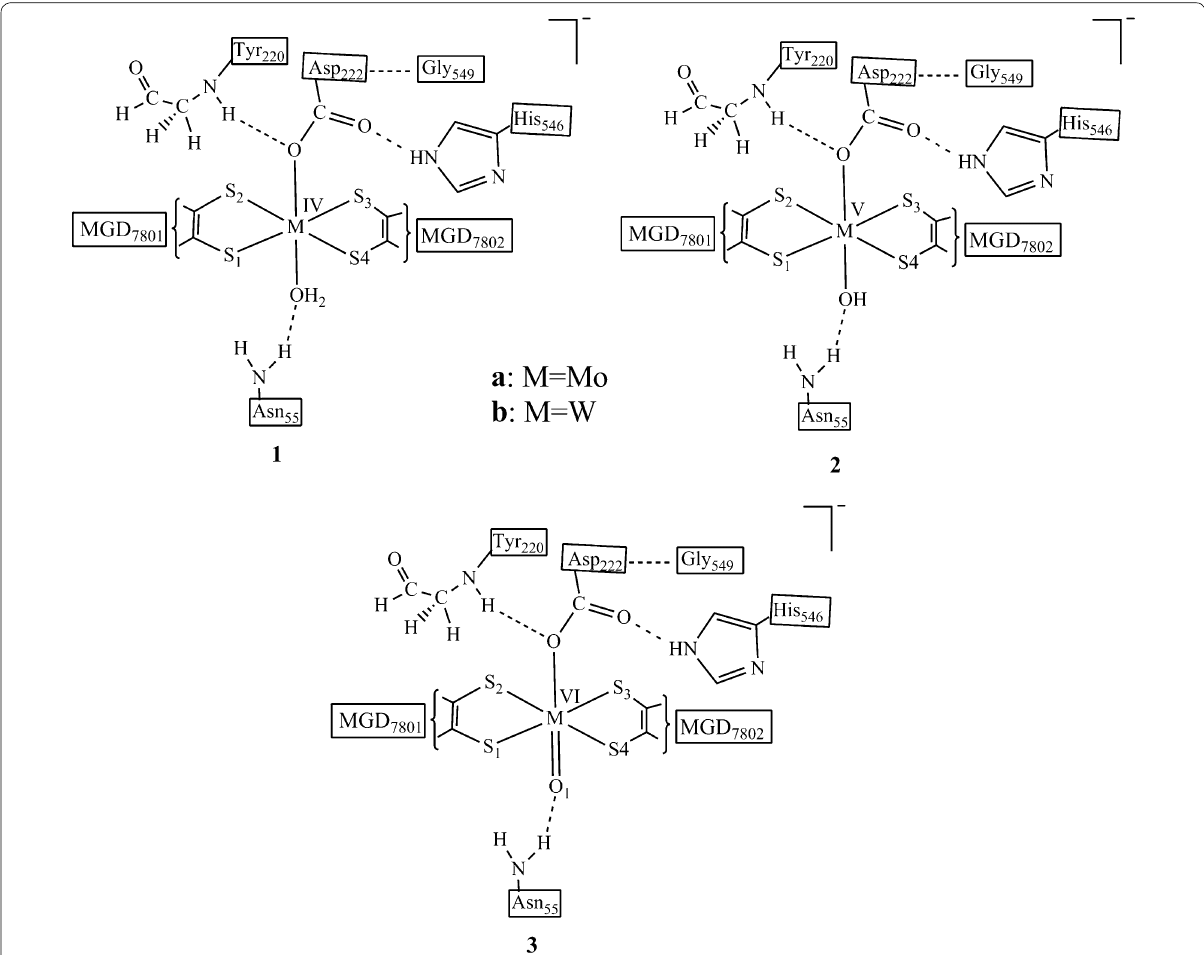
Fig. 4 The chemical structure of the active site model complexes 1 and 2 derived from the protein X-ray crystal structure of Nar (PDB ID 1R27)